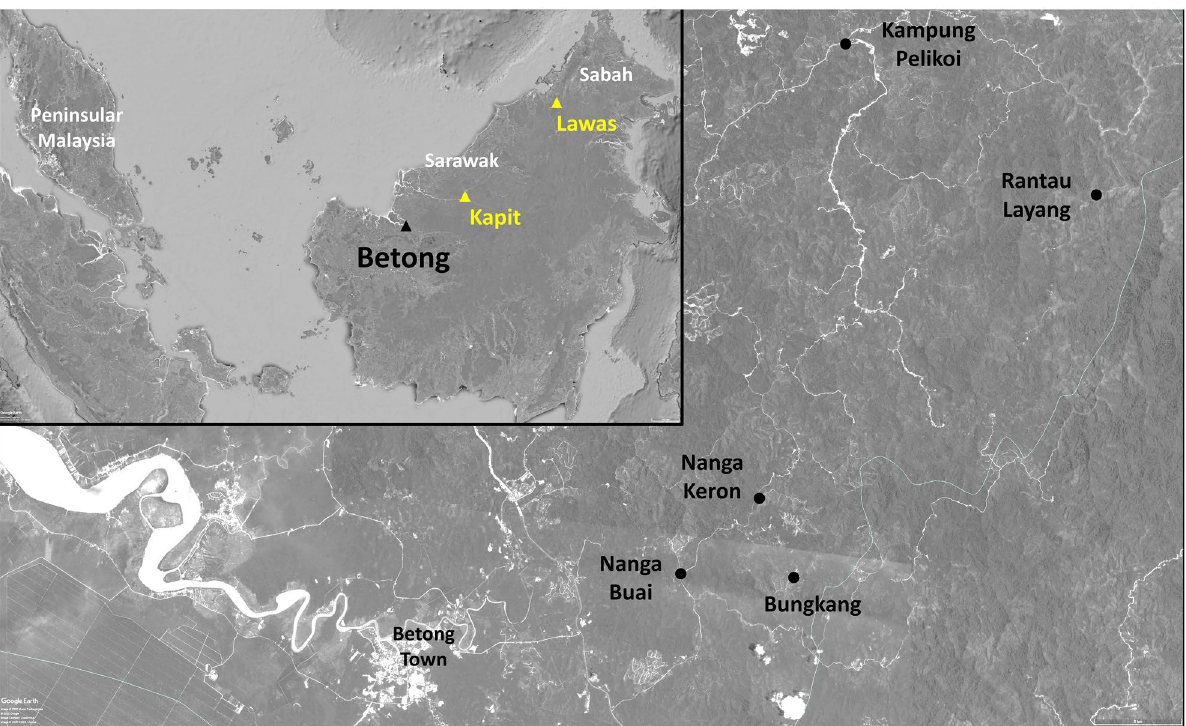
Figure 5. Map showing the five villages (black circles) of mosquito collection sites relative to Betong town and inset map showing where previous studies (yellow triangles) on vectors of knowlesi malaria were conducted in Sarawak. The images were obtained from Google Earth Pro 7.3.3.7786 (https:// www. google. com/ intl/ en_ uk/ earth/ versi ons/# earth- pro) 58